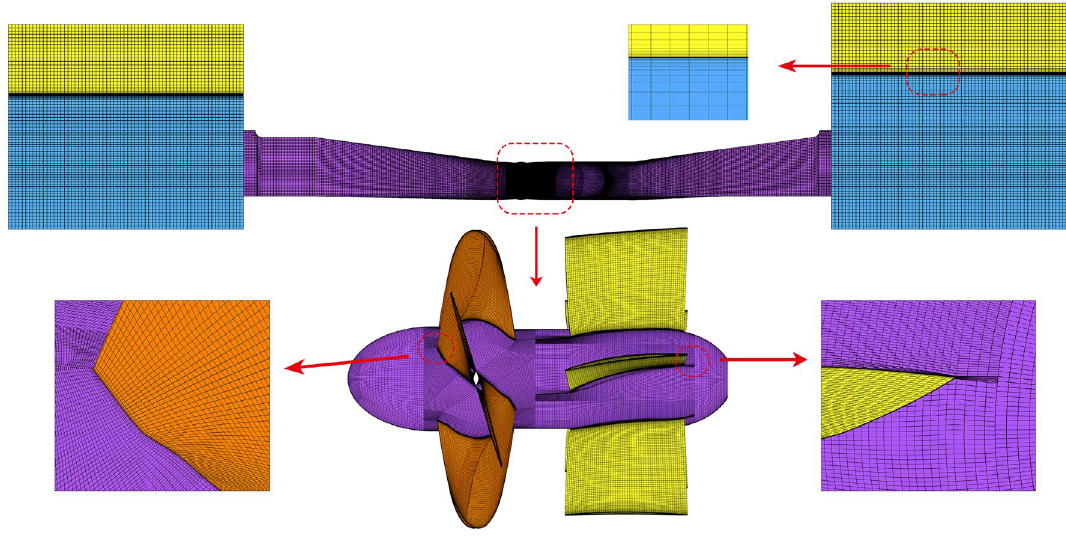
Figure 4. Computational grids of flow